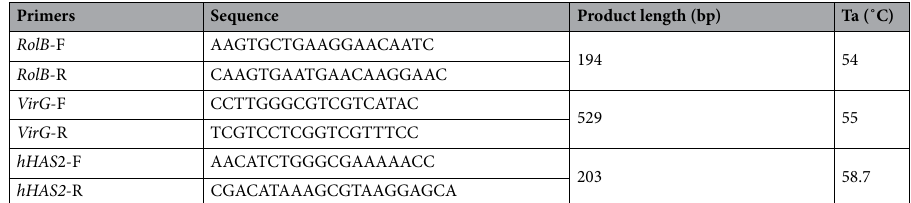
Table 6. Sequences Of the primers used for PCR-based characterization of the transgenic lines and the resulting product sizes. The primers were designed using Vector NTI 11 and Allele ID 7 software. Ta temperature annealing, F forward, R